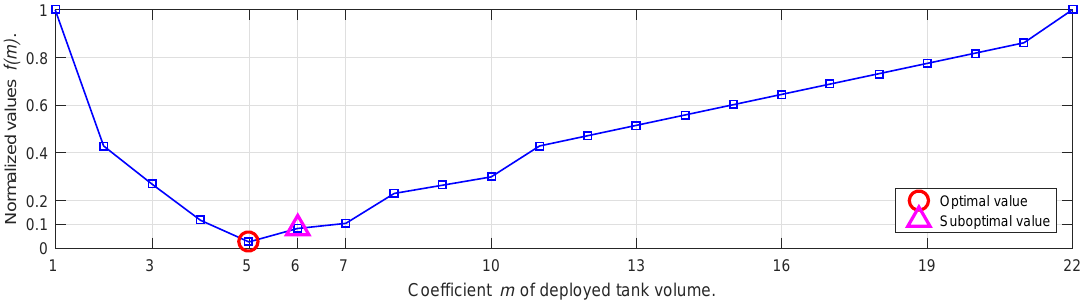
Figure 9. The solution of the optimal value f ( m ) is based on the load factor m